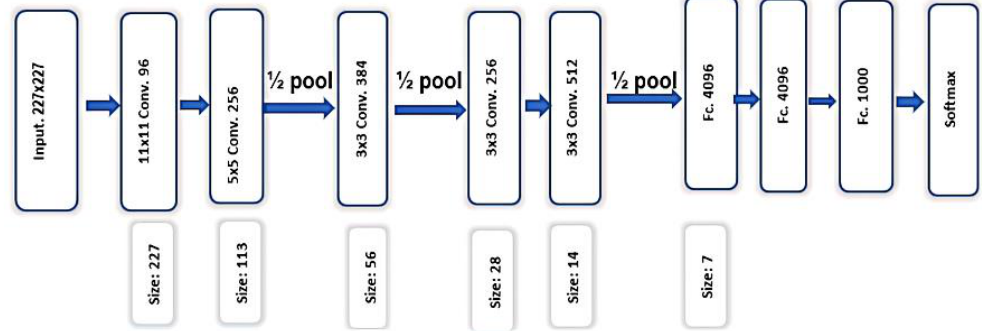
Figure 10. Alex-Net architecture.